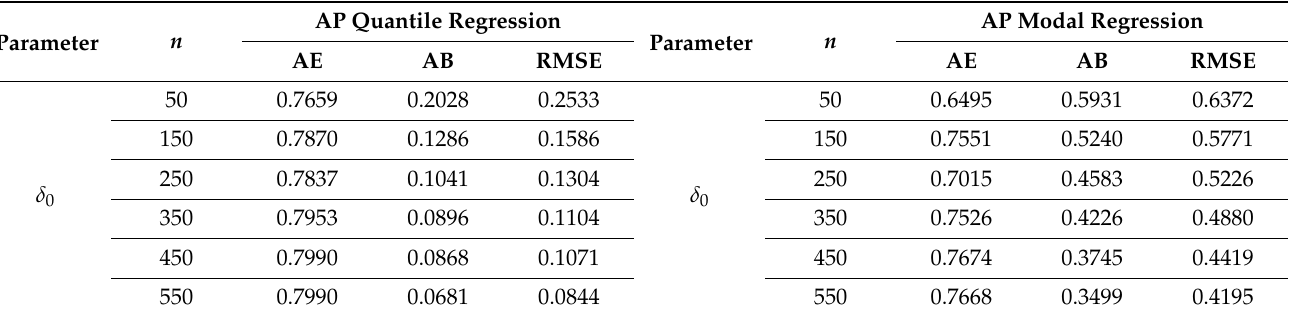
Table 5. Simulation results for the first